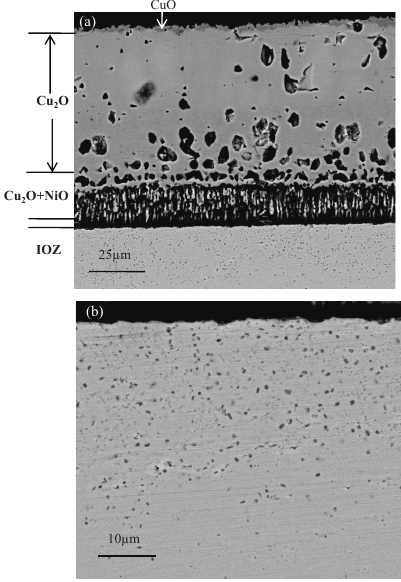
Figure 6. BEI micrographs of a cross section of Cu-3Ni oxidized at 800 °C in 1 atm O 2 for 30 min. (a) General view; (b) Enlarged view of the IOZ.